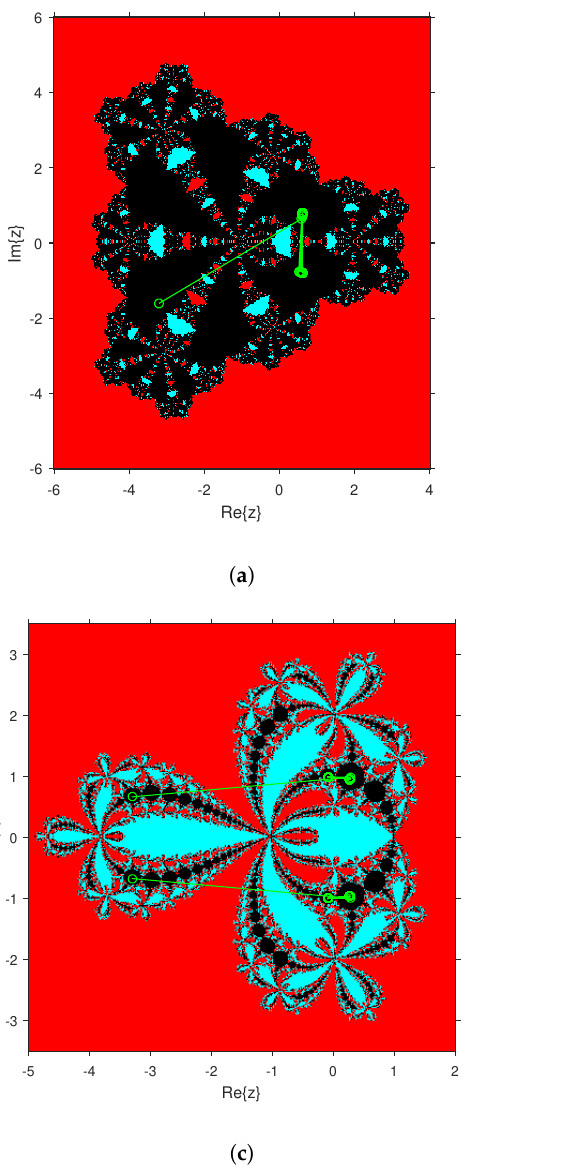
Figure 9. Dynamical planes. ( a ) θ = 20, ( b ) θ = 15.5, ( c ) θ = − 6.5, ( d ) θ = 25 − 26 i . At the end, we provide dynamical planes for θ = − 0.5, θ = 0, θ = 0.2 and θ = 2 in Figure 10a–d, respectively. The attraction basins in these planes are related to v 1 or v 2 only; as a consequence, the corresponding elements of the considered family are numerically stable. Thus, these methods are preferable over other elements of the family in most numerical